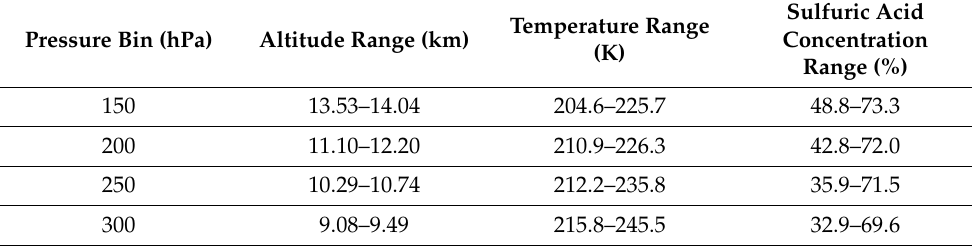
Pressure Bin (hPa) Altitude Range